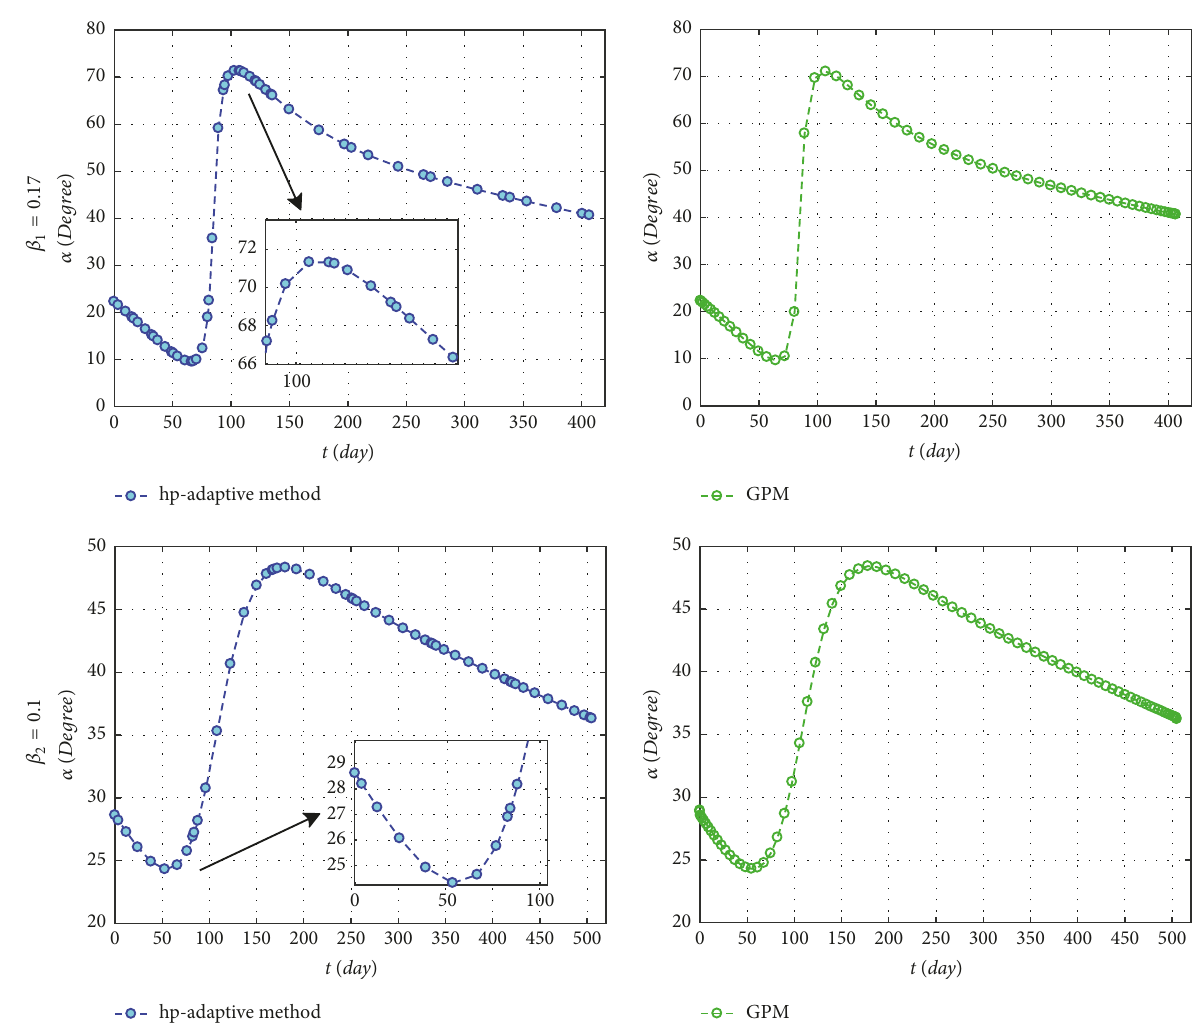
Figure 9: The required pitch angle of the optimized trajectory.